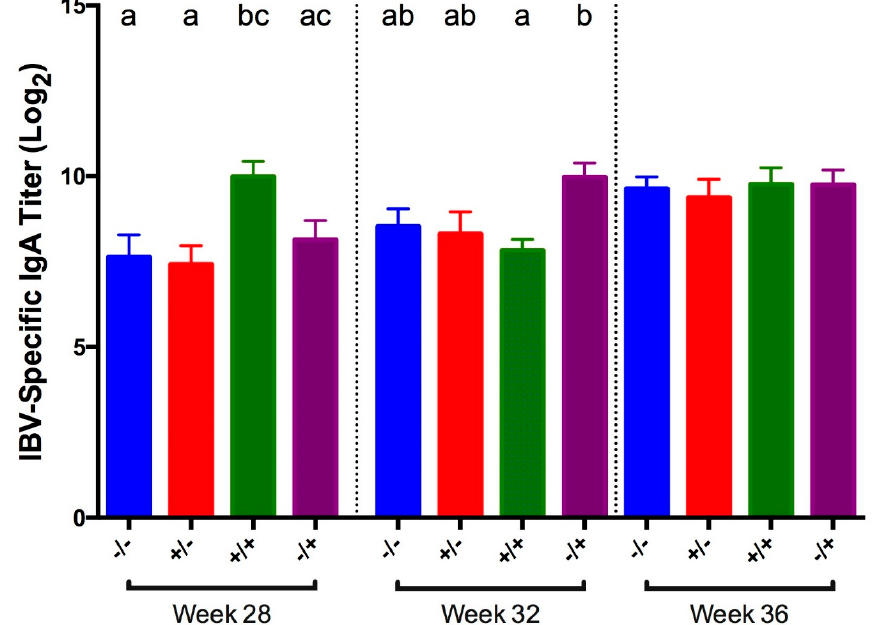
Figure 3. Tear IBV-specific IgA titer in tears collected 5 days post-challenge with IBV GA98 for different groups of birds challenged at 20, 24, 28, 32, and 36 WOA. Letters (a–c) indicate significant differences among vaccine and challenge groups for each week ( p < 0.05). − / − = non-vaccinated/non-challenged, +/ − = vaccinated/non-challenged, +/+ = vaccinated/challenged, − /+ = non-vaccinated/challenged.